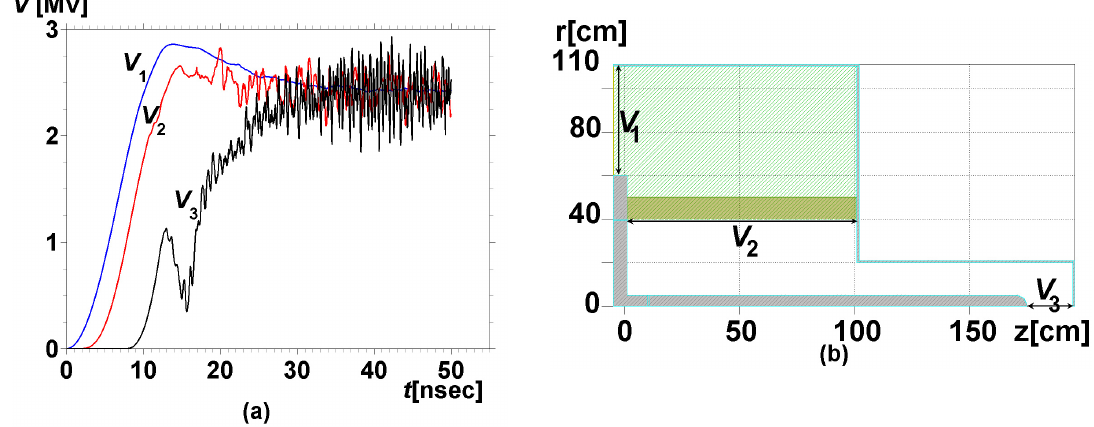
FIG. 9. (Color) The voltage vs time (a) as measured at various locations during the PIC calculation performed on the system shown in (b). The geometry of the PIC calculations in 9(b) is the same as that in